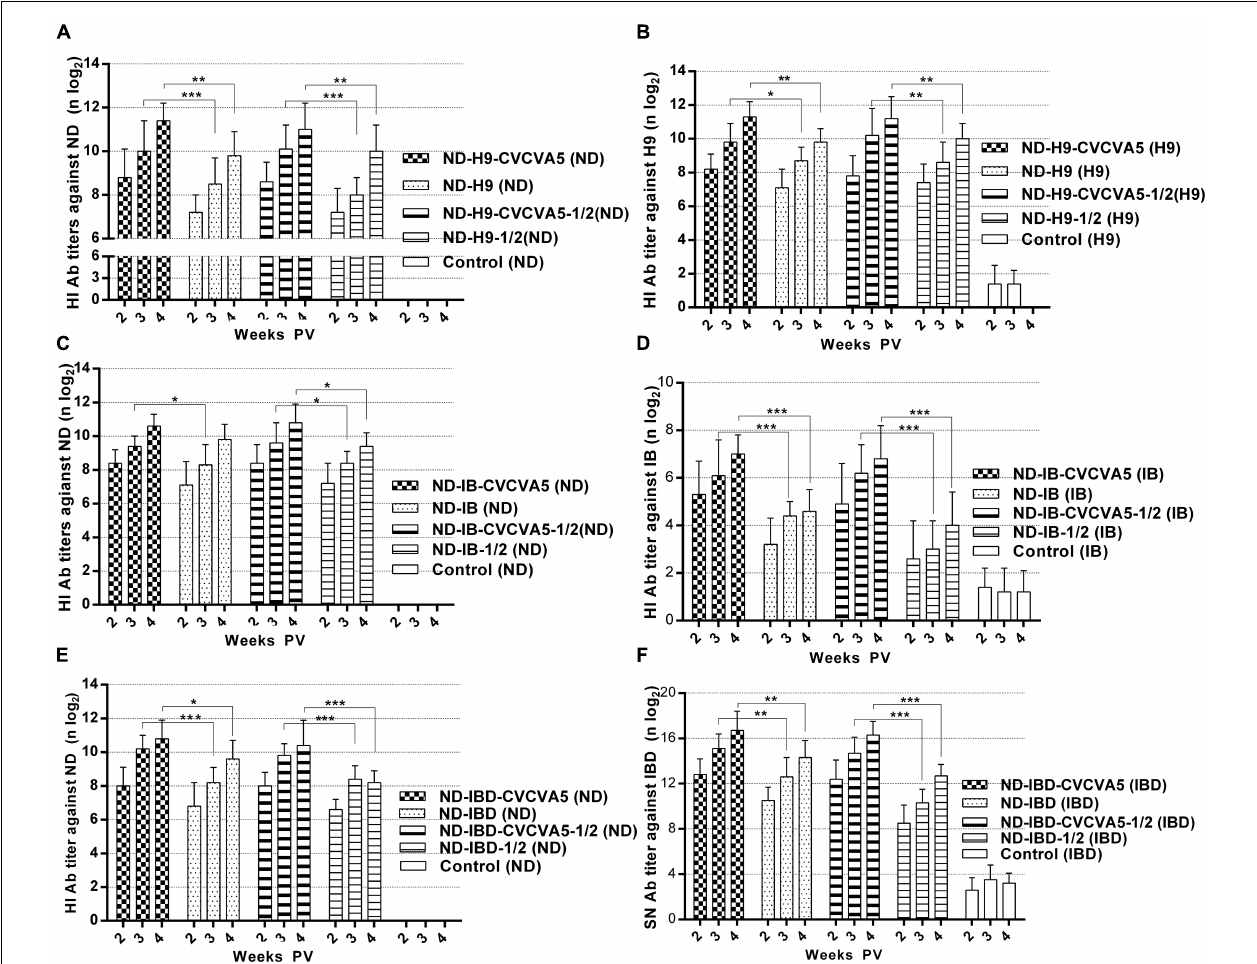
FIGURE 3 | Antibody titers against virus antigen of the bivalent vaccines. ND-H9-CVCVA5, one dose of CVCVA5 adjuvanted ND-H9 vaccine. ND-H9, one dose of commercial ND-H9 vaccine without CVCVA5. ND-H9- CVCVA5-1/2, half-dose of CVCVA5 adjuvanted ND-H9 vaccine. ND-H9-1/2, half dose of ND-H9 commercial vaccine (A,B) . The name of ND-IB (C,D) and ND-IBD (E,F) vaccines groups were similar to those of ND-H9 vaccines. ∗ P < 0.05, ∗∗ P < 0.01, ∗∗∗ P < 0.001.